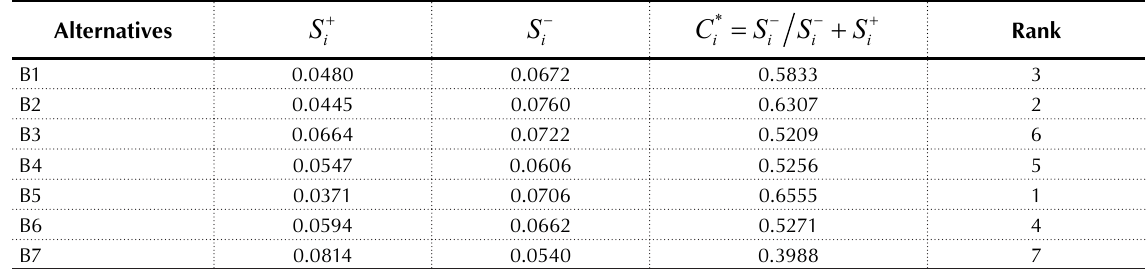
Source: Compiled by